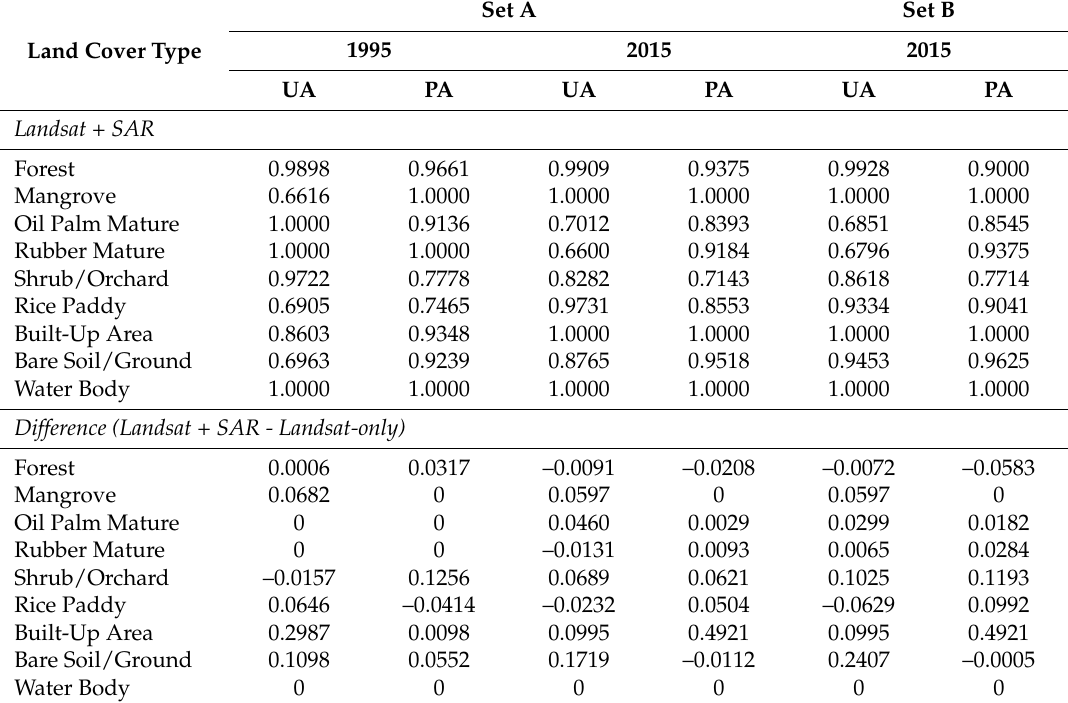
Table 5. User’s (UA) and producer’s (PA) accuracies of land cover classes from the classification results of Landsat + SAR data, and the difference of UA and PA between Landsat + SAR vs. Landsat-only data. Numbers in bold indicate an improvement of at least 10% over Landsat-only data, and negative values indicate lower UA and PA for Landsat + SAR compared to Landsat-only